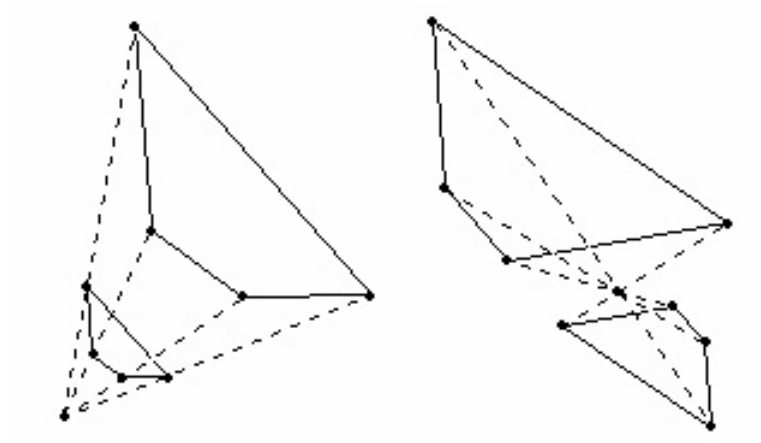
Figure 5. Homothetic